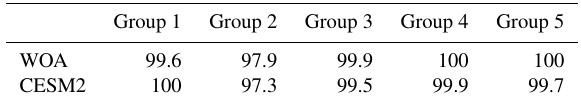
Table 2. The coverage (%) of the majority group of DBSCAN in the total non-outlier